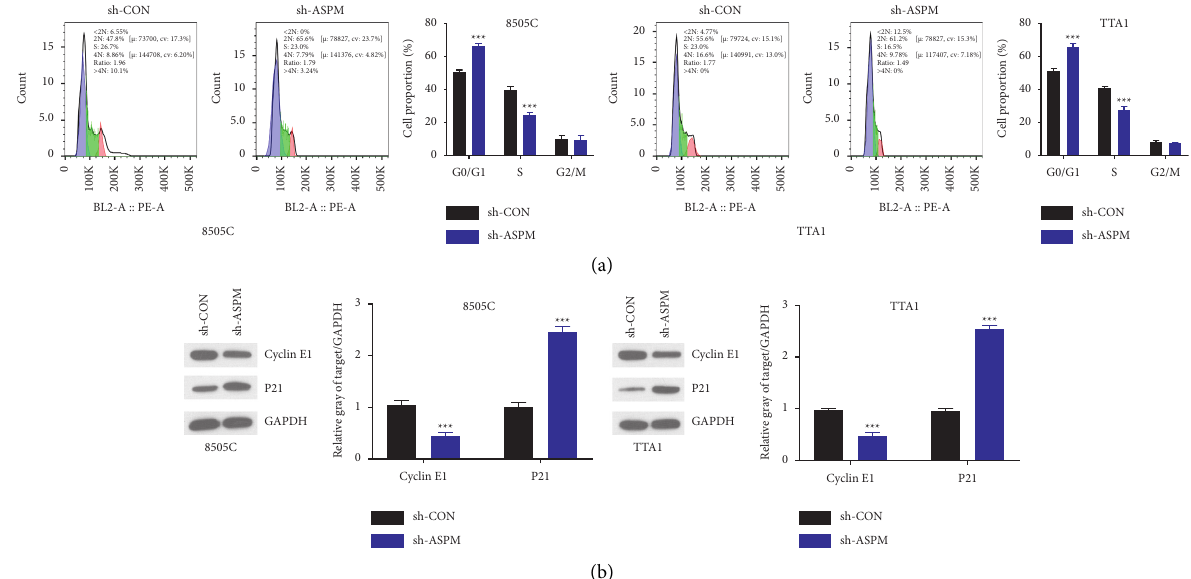
Figure 3: ASPM inhibition induces cell cycle arrest of ATC cells. (a) Cell cycle was analyzed by flow cytometry. (b) The expression of cyclin E1 and P21 was detected using western blotting. ∗∗∗ P < 0 . 001.